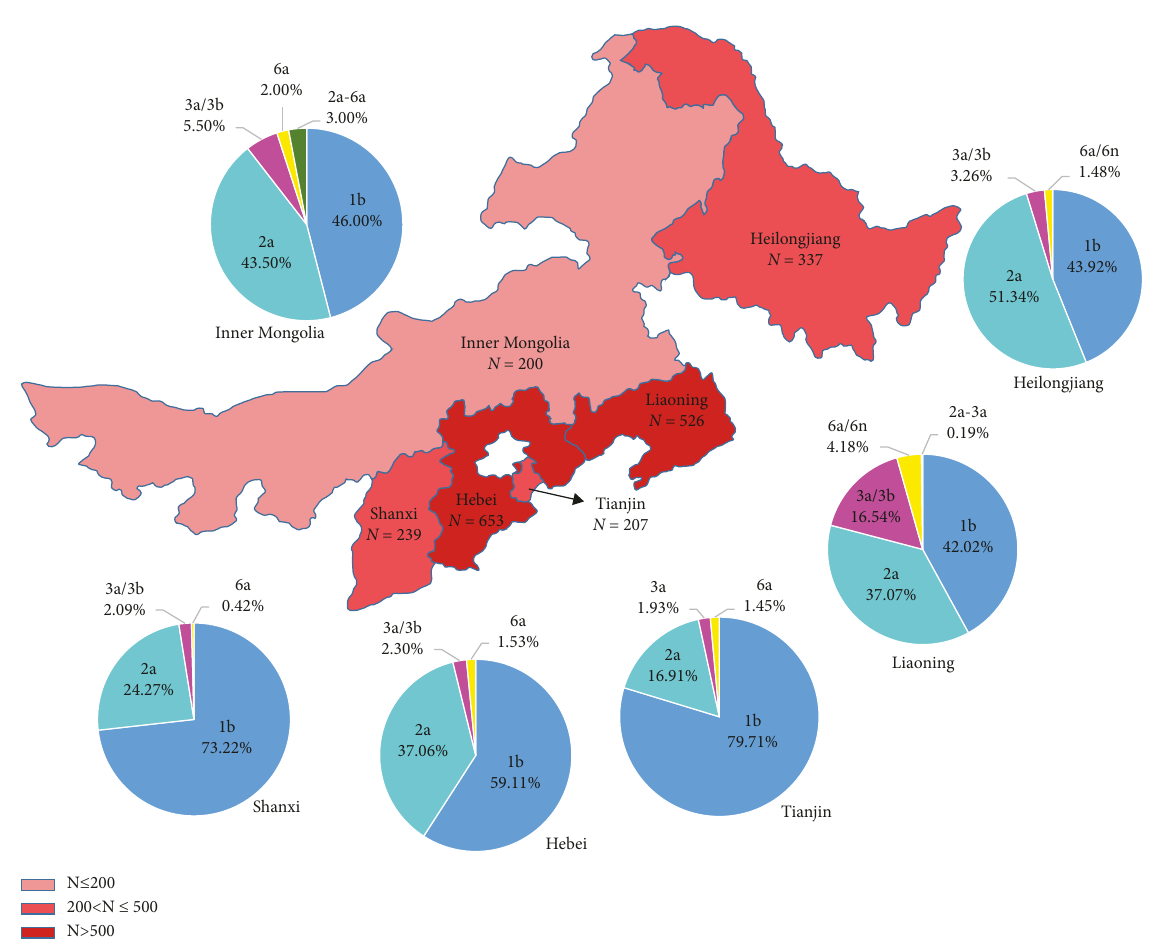
Figure 2: Geographical distribution of HCV genotypes in different provinces/municipalities of North and Northeast China. The numbers of cases in different regions are shown in red on different scales. The numbers and proportions of different HCV genotypes in each region are presented by pie graphs with different